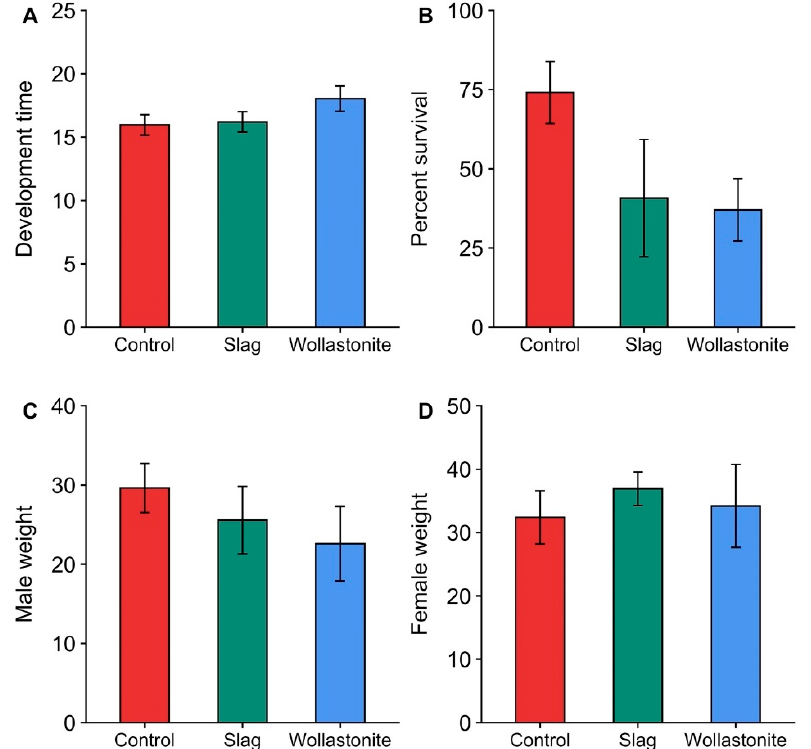
Figure 2. Means ( ± SE) of ( A ) nymph development time (days), ( B ) survival to adult stage (%), and adult weights (mg) of 1 d-old ( C ) male and ( D ) female Oebalus pugnax reared on panicles taken from rice ( Oryza sativa ) plants treated with silicon (@ 1120 kg/ha) provided in the form of slag, wollastonite, or untreated control in the laboratory at 27 ± 1 ◦ C and 14:10 h L:D